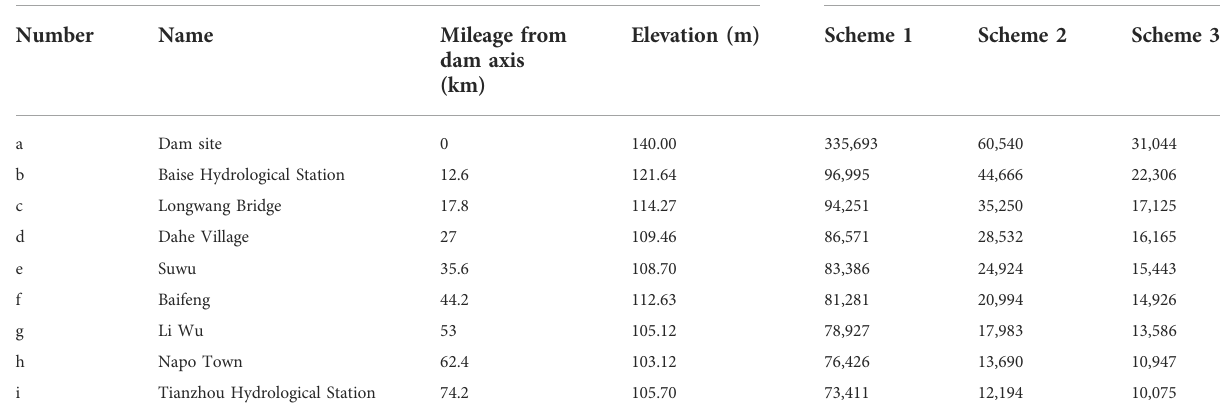
TABLE 5 Maximum fl ood peak fl ow along the dam